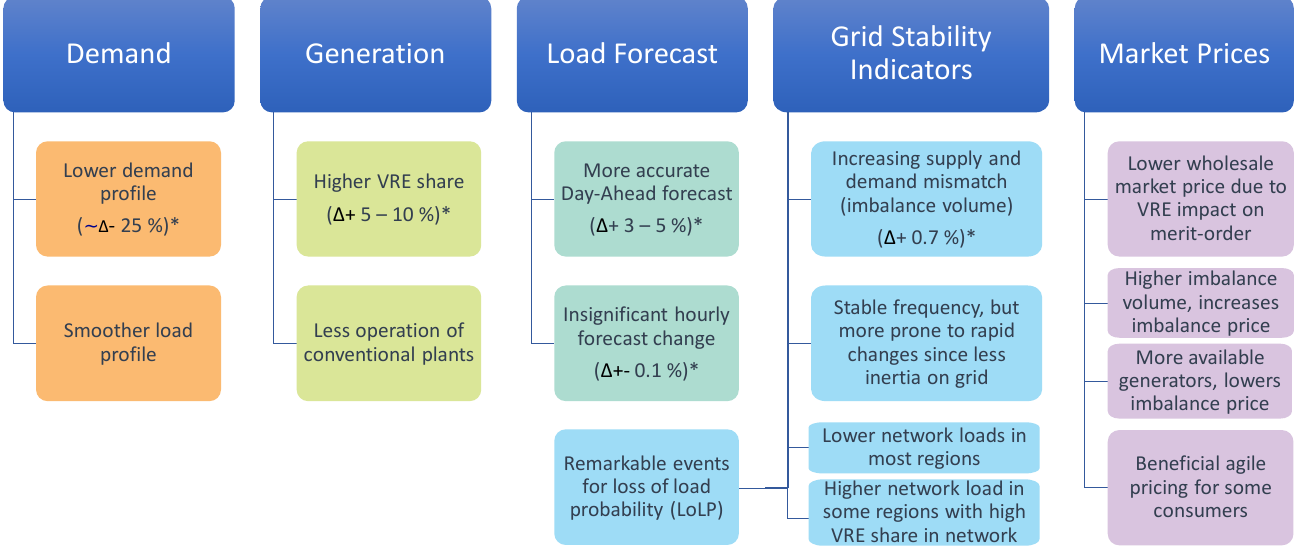
Figure 20. Summary of key results. The asterisk (*) notes that the effect of some factors such as economic climate were not taken into account. More details on whether these changes are representative are in Section